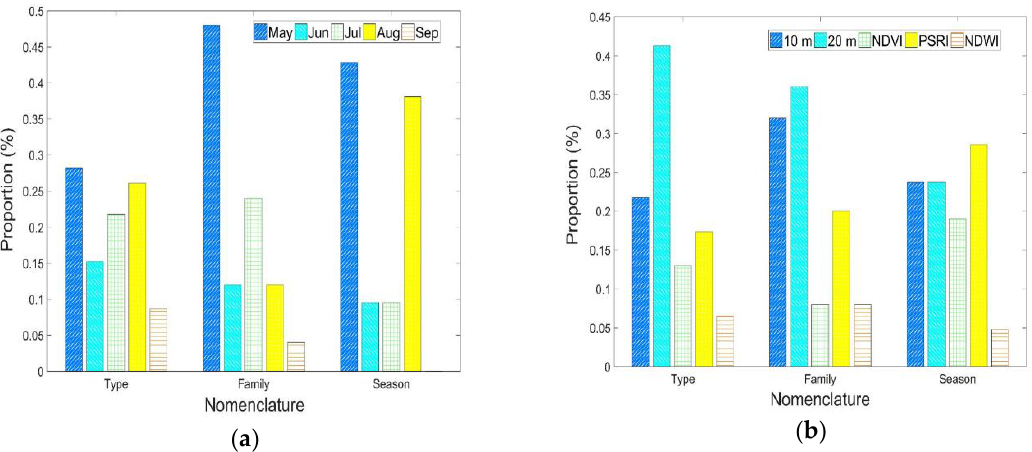
Figure 7. Proportion of feature contribution bar graphs for the Sentinel-2 scenario, calculated based on the feature importance values. The two figures are plotted for two thematic categories ( a ) month of image acquisition and ( b ) spectral information.